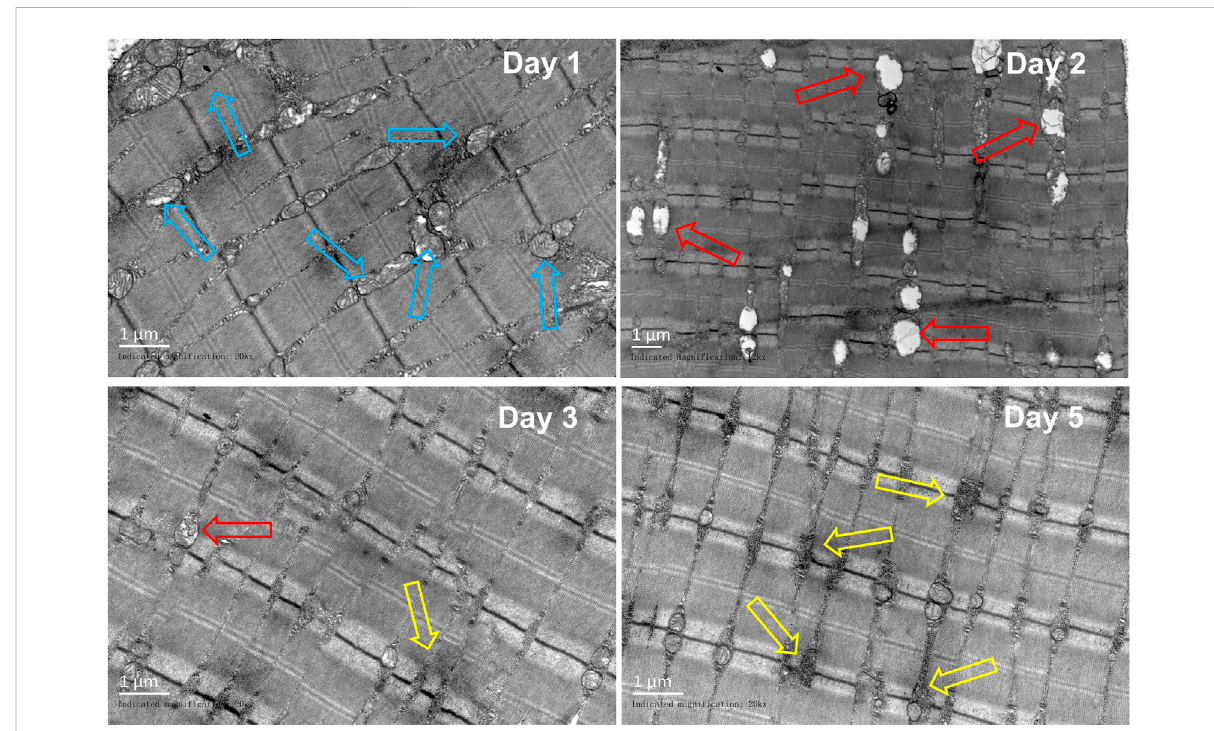
FIGURE 9 RepresentativeTEMimagesofthegastrocnemiusatdifferentperiods( n =10).Scalebar=100 μ m.Bluehollowarrowsindicatethesarcoplasmic reticulum, red arrows indicate the mitochondrion, and yellow arrow indicates the